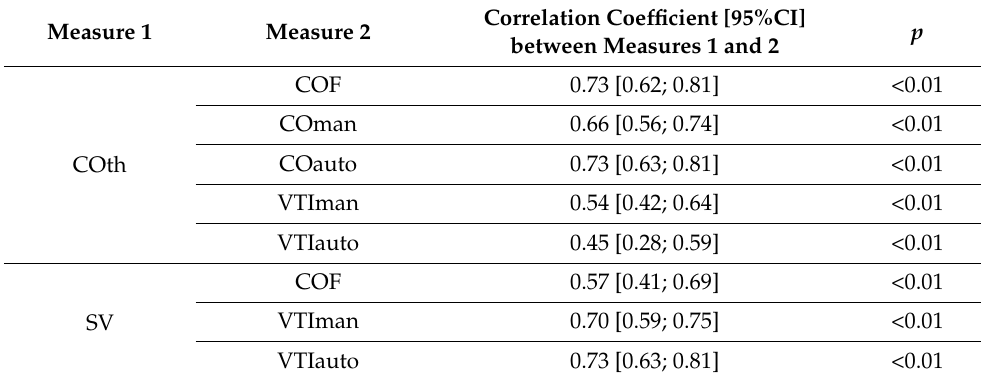
Figure 3. Variations of CO (L.min − 1 ) during the experiment. ( A ) CO as measured by thermodilution (COth); ( B ) CO calculated by ultrasound device with a manually measured sub-aortic velocity time index (COman); ( C ) CO calculated by ultrasound device with an automatically measured sub-aortic velocity time index (COauto); ( D ) CO flux (COF). Table 2. Correlation coefficients between measures for the primary and secondary